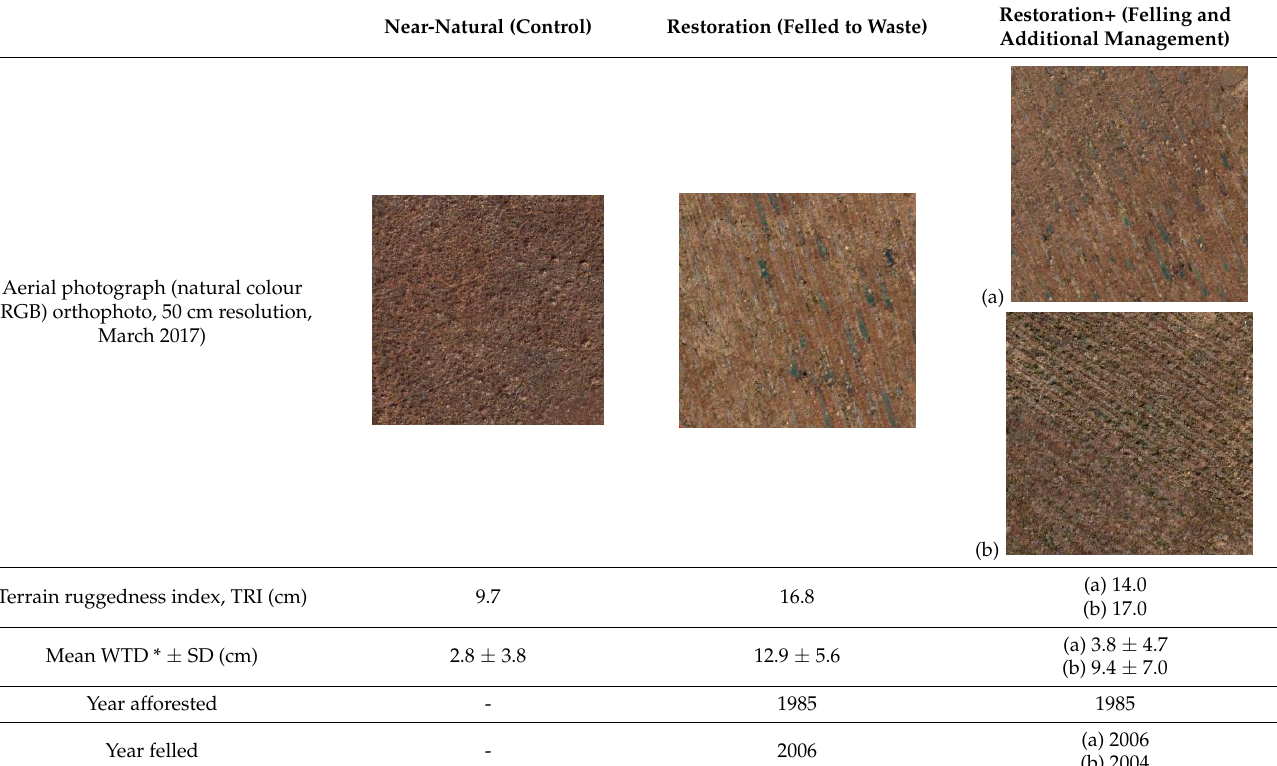
Table 2. Forsinard Flows Lonielist sites’ characteristics. Two Lonielist restoration sites with additional management were used in this study and are described as (a) LO_BCFB and (b) LO_CT. * Mean water table depth between 15 September 2018 and 31 July 2020.